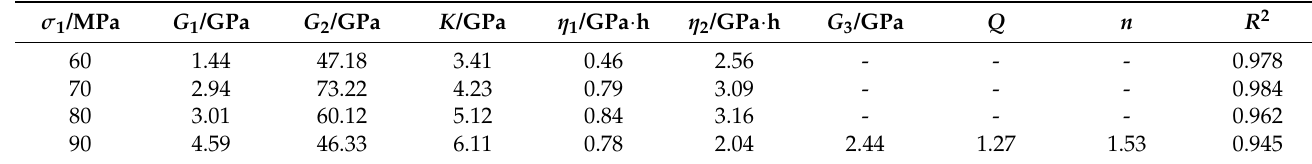
Table 5. Parameter table of creep fatigue